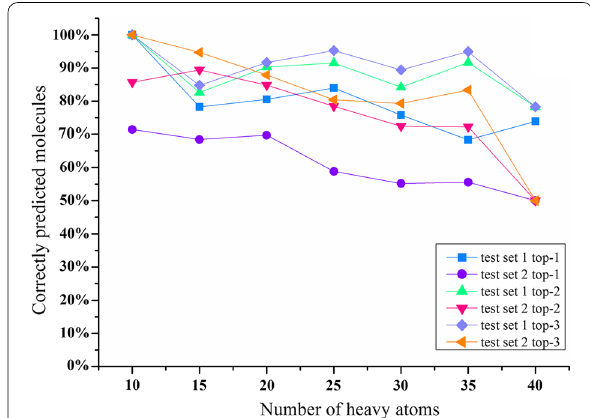
Fig. 6 Percentage of correctly predicted molecules with respect to their size for test set 1 and test set